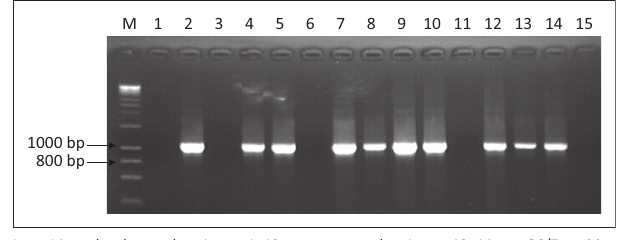
FIGURE 3: A 2.0 % agarose gel showing Echinococcus granulosus NADH 1 gene RFLP analysis results.